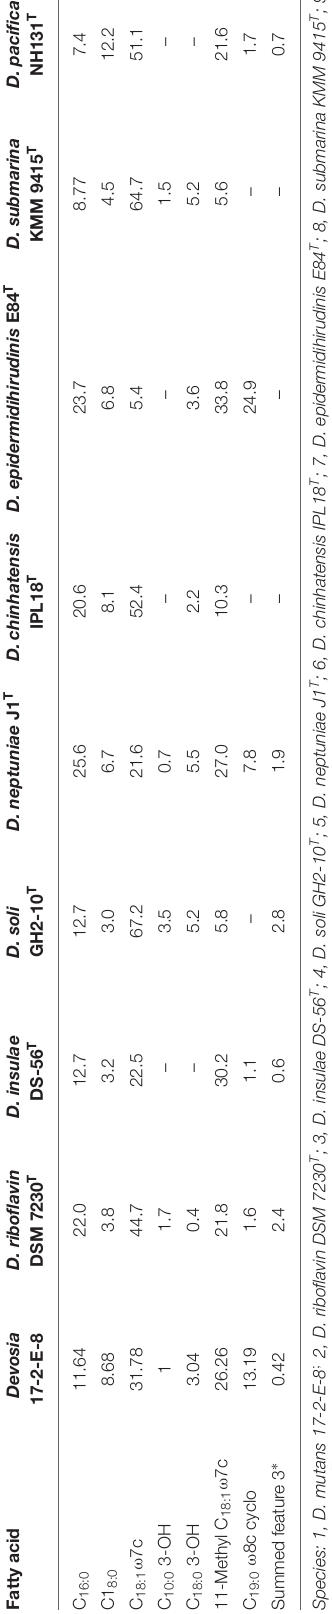
proposed to explore its full-potential especially in the light of the recently confirmed abrogation of toxicity of 3 -epi -DON (He et al.,